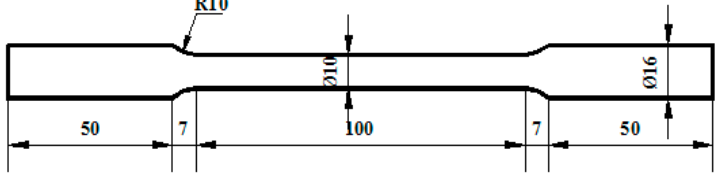
Figure 1. Geometry of round bar specimen (mm).